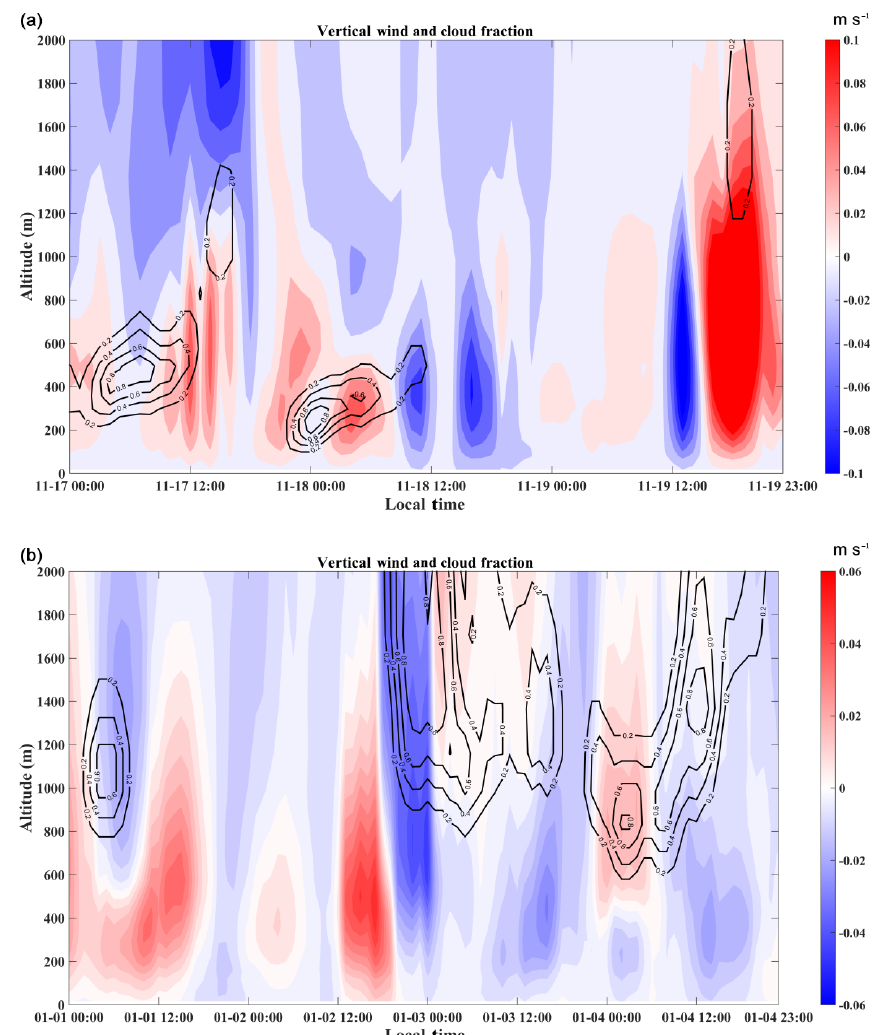
Figure 8. Distribution of vertical wind (color scale: red – upward; blue – downward) and cloud fraction (black contour line) simulated by the WRF model during (a) autumnal and (b) winter